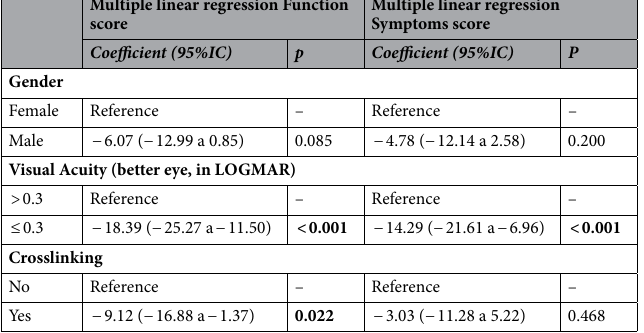
Table 6. Multiple linear regression to functional and symptoms scores according to stepwise backwards modeling.